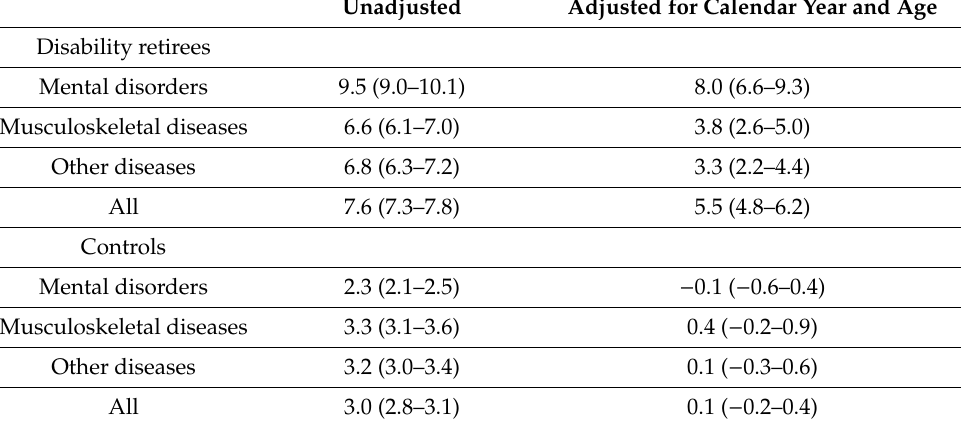
Table 2. The e ff ect of adjusting for calendar year and age on the increasing number of unemployment days before disability retirement. Mean increase in the number of unemployment days per one year of approaching disability retirement (95% confidence intervals). The last year before disability retirement